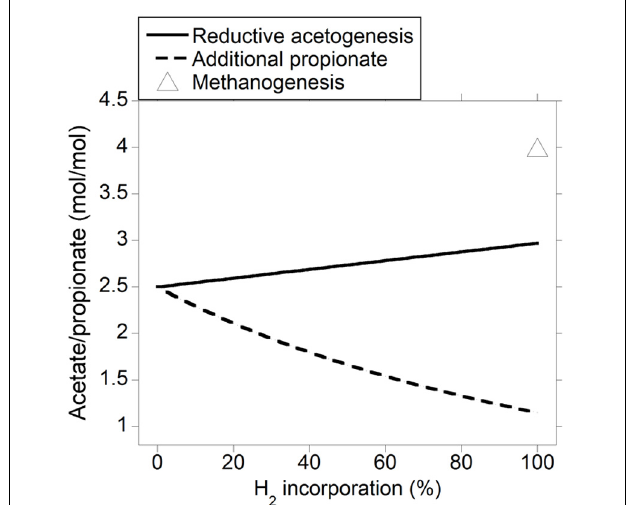
FIGURE 3 | Response of the acetate to propionate molar ratio to H 2 incorporation into reductive acetogenesis or additional propionate formation. Corresponding fermentation with CH 4 as main electron sink is provided as reference.